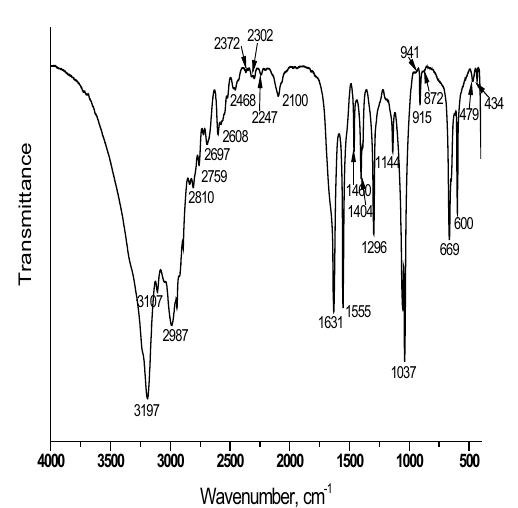
Figure 9. SEM of the G/S (75:25: wt.%) hybrid before immersion in 1.5 SBF